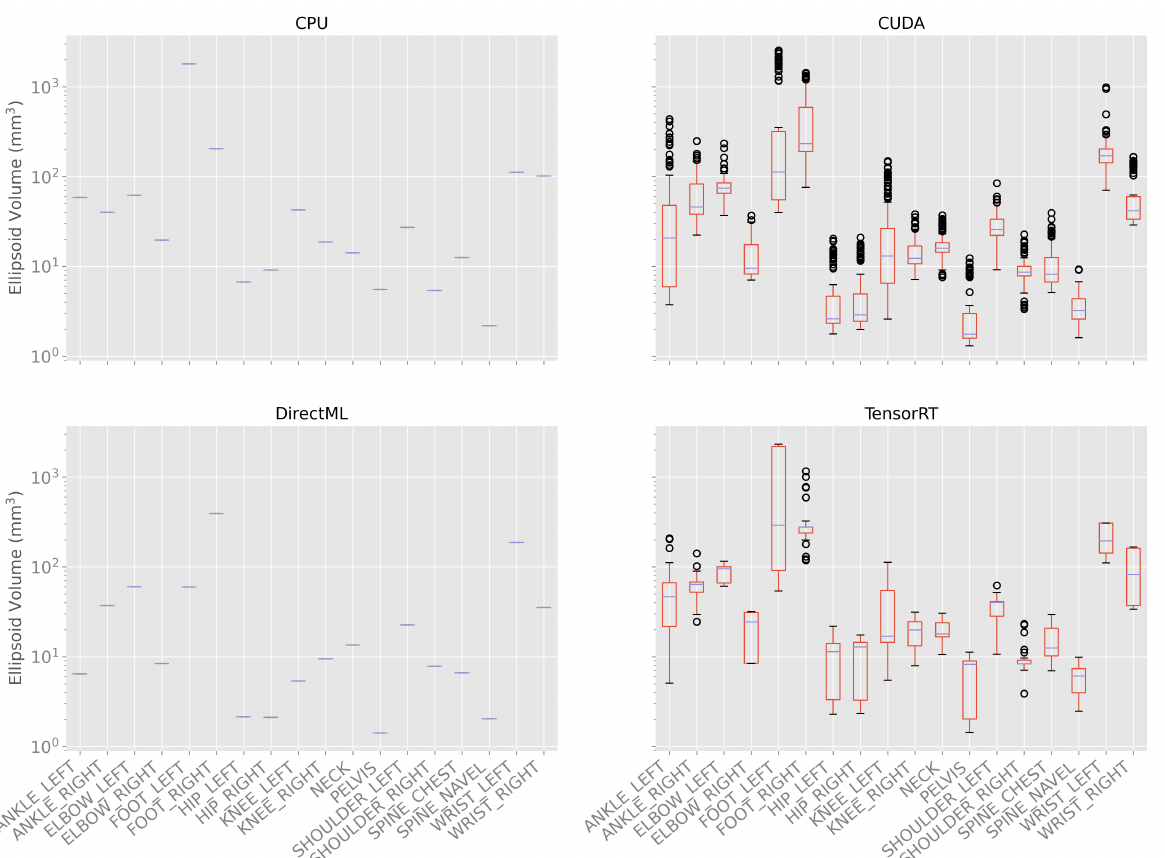
Figure 6. Box plots of the ellipsoid volumes for all processing modes for the 100 body tracking runs. As the standard deviation for processing modes CPU and DirectML is zero, only the mean is shown for these modes. Note: the y -axis has a logarithmic